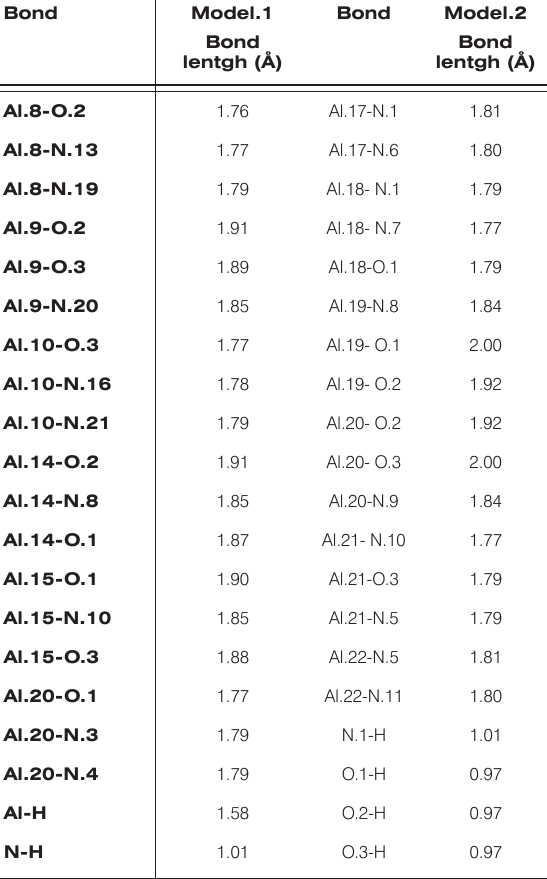
Table 1. Structural data of representative models of the O-decorated AlNNTs. Model.2BondModel.1Bond